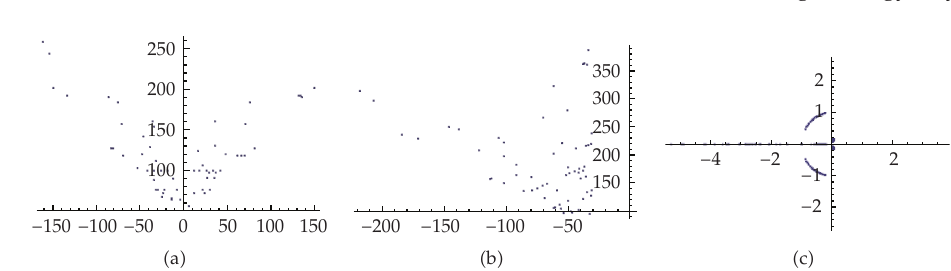
Figure 9: (cid:5) a (cid:6) The Hodge numbers, with h 1 , 1 − h 3 , 1 as the abscissa and h 1 , 1 (cid:8) h 3 , 1 , the ordinate, of the fourfolds which have vanishing Euler number, and hence rank exceeding unity. (cid:5) b (cid:6) The same, but with h 1 , 1 − h 2 , 1 , as the abscissa and h 1 , 1 (cid:8) h 2 , 1 as the ordinate. (cid:5) c (cid:6) The position of the roots, on the complex plane, of the Poincar´e polynomial of these 61 spaces out of the some 3 million.